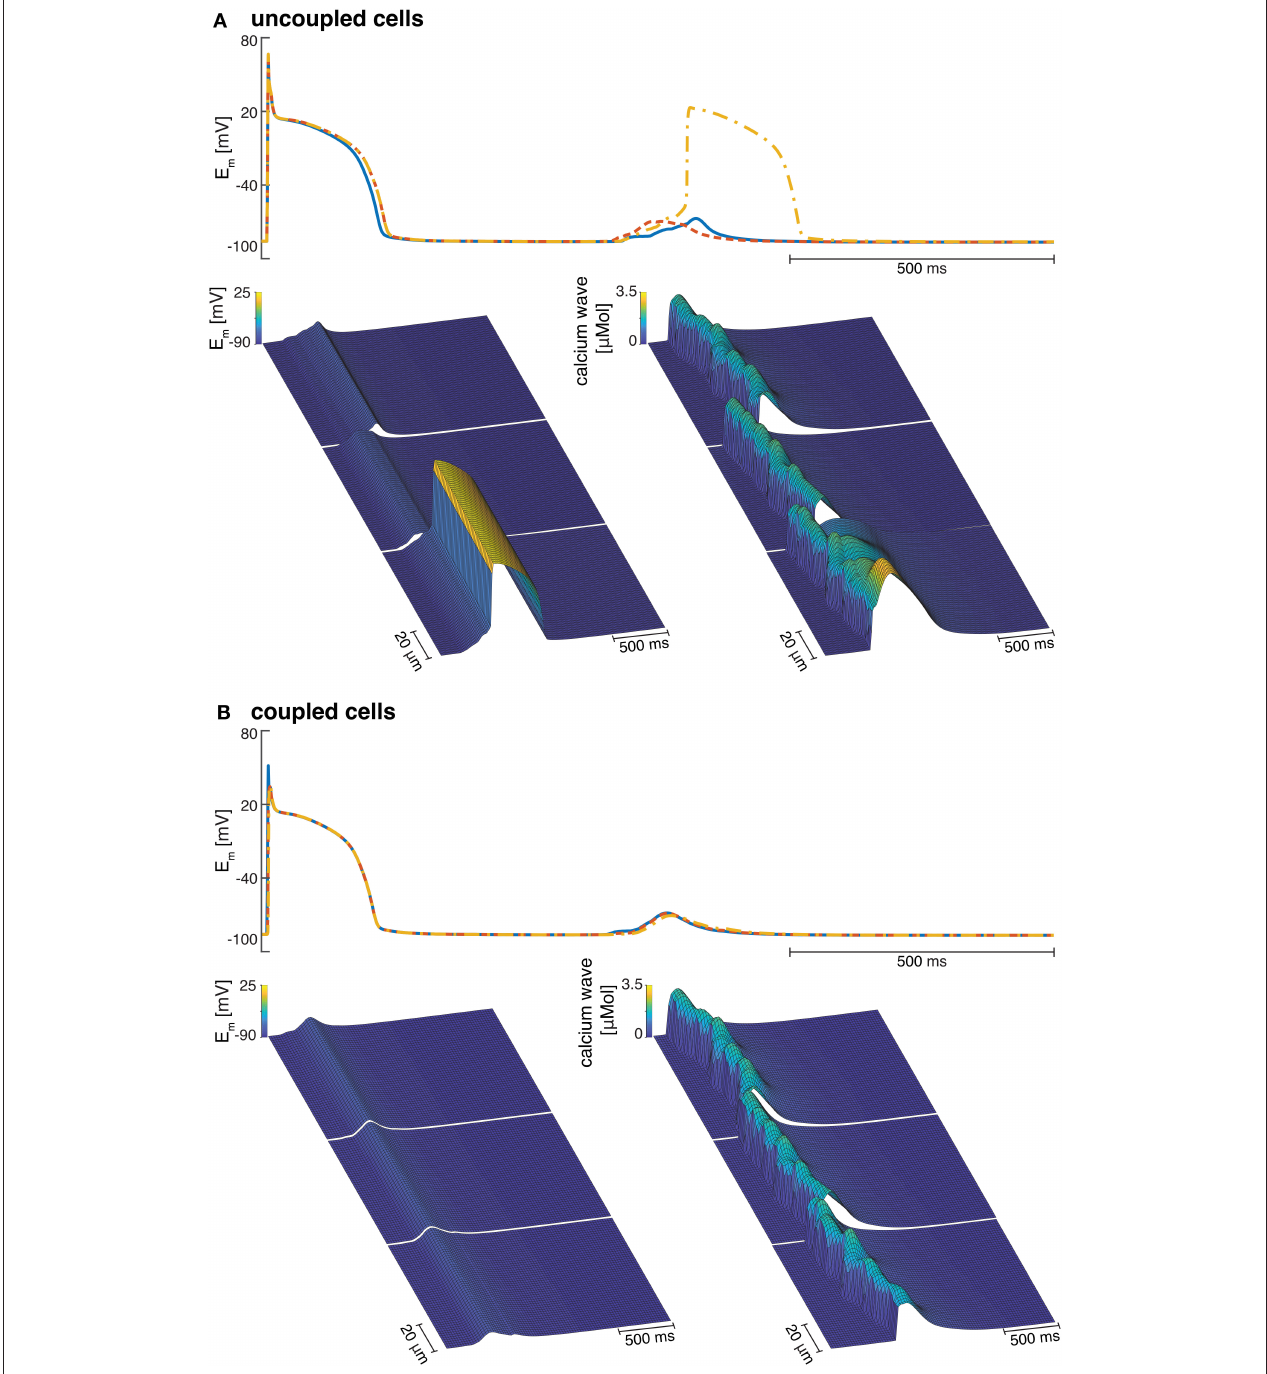
FIGURE 7 | (A) Examples of three isolated myocyte APs of the last stimulated beat and the calcium mediated DAD (top), a detailed view of the DAD (bottom left), and the calcium waves in three single cardiomyocytes coupled to three fibroblasts each (bottom right). (B) Example of the APs of three coupled myocytes showing the last stimulated beat and the DAD (top), a detailed view of the DAD (bottom left), and the calcium waves in three coupled cardiomyocytes coupled to three fibroblasts each (bottom